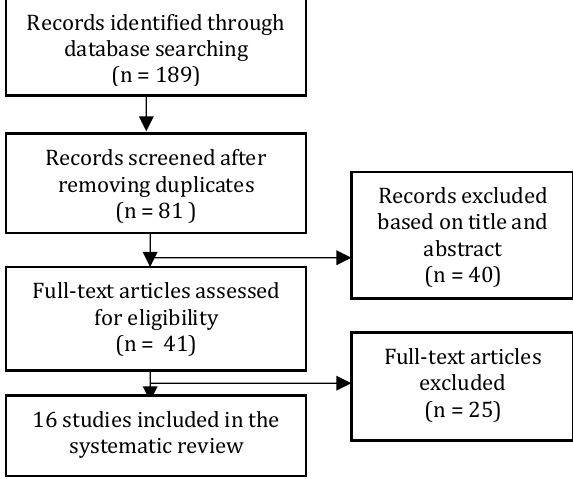
Figure 1. Diagram summarizing the literature